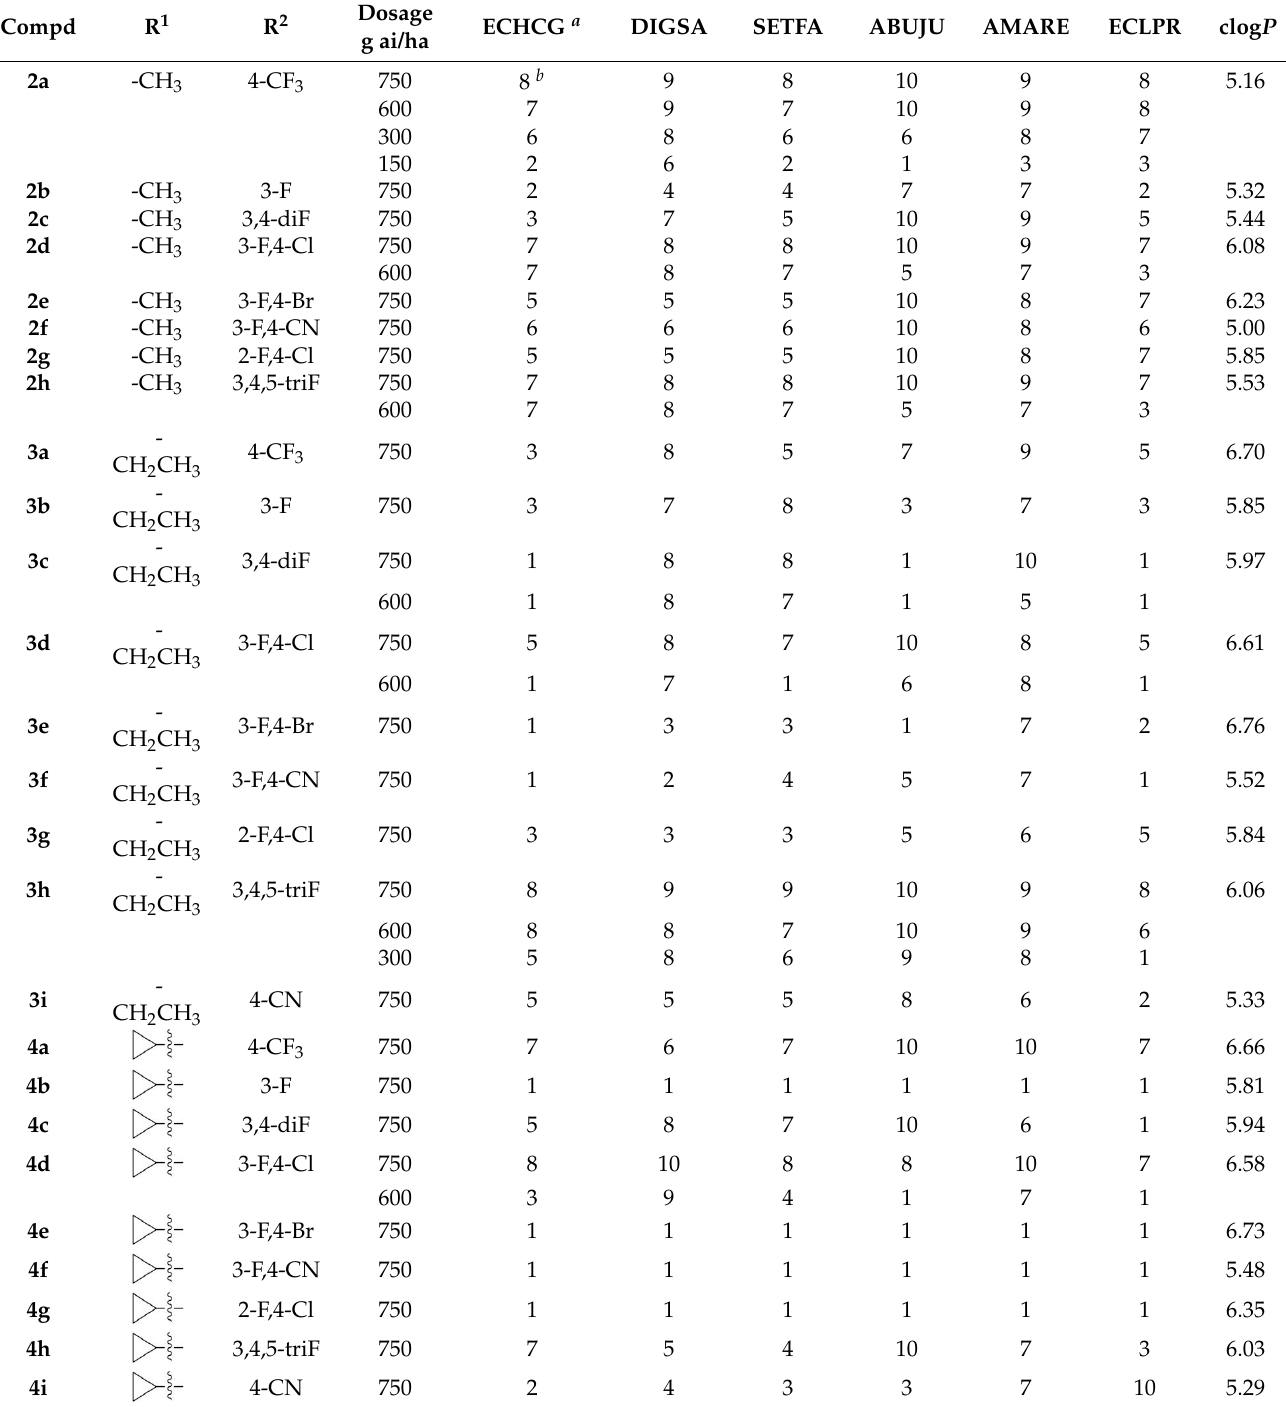
Table 1. The post-emergence herbicidal activity of compounds 1 – 5 and